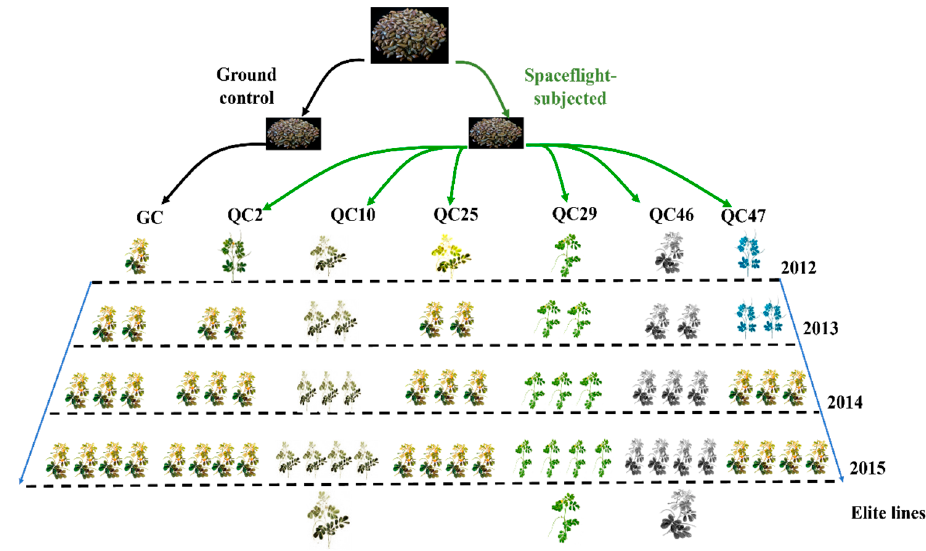
Figure 1. Schematic model of S. obtusifolia breeding program. In 2012, the first generation (SP 1 ), SP-lines seeds were cultivated, and their critical biological trait was observed carefully. Several mutants were found in SP 1 population. Seed of each line was conducted seed trait and HPLC analysis. In 2013, seeds of different lines were cultivated, and their biological trait was investigated. It was found that QC2 and QC10 cannot maintain its variation trait and exhibit the similar phenotype to GC-line. In 2014, the variation trait of QC47 was not maintained. After a three-year study, three SP-lines (QC10, QC29, and QC46) were chosen as elite lines for the further